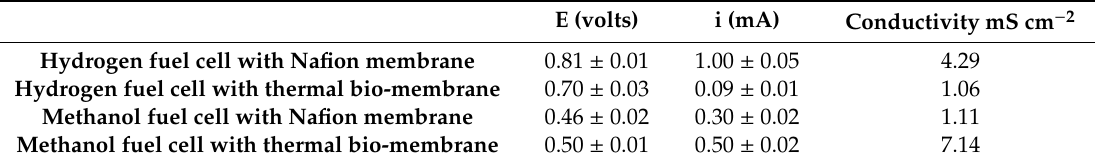
Table 2. Electric data of the bio-membrane performance in a methanol fuel cell and hydrogen fuel cell at room temperature (298